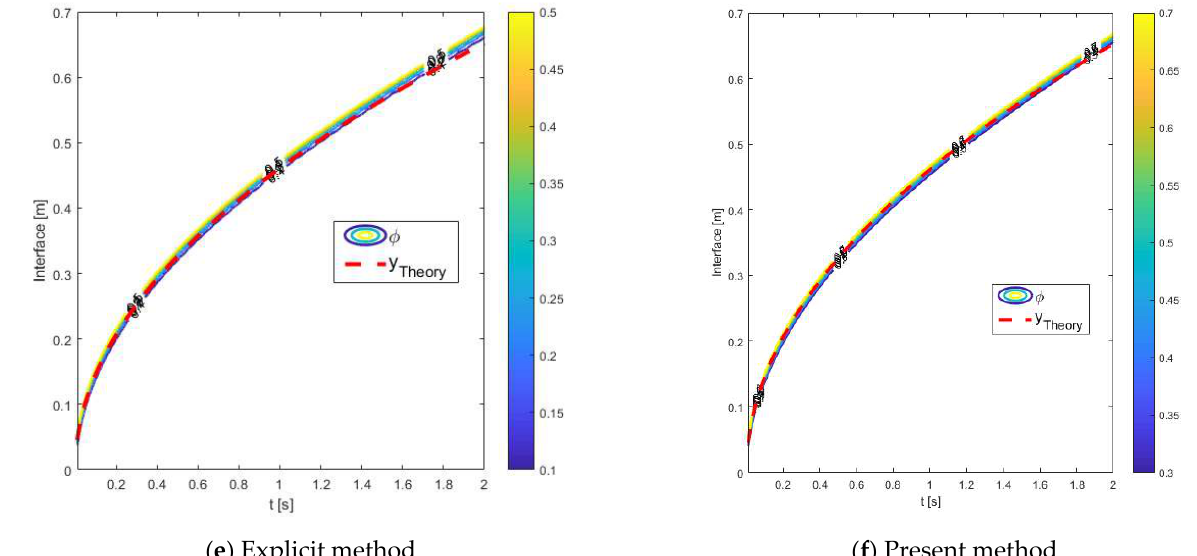
Figure 2. Depth from surface to thawing interface calculated by the explicit method, the present method, and the analytical solution for different ɸ values and grid resolutions: ( a , b ) 20 × 20 grid resolution; ( c , d ) 40 × 40 grid resolution; ( e , f ) 80 × 80 grid resolution.